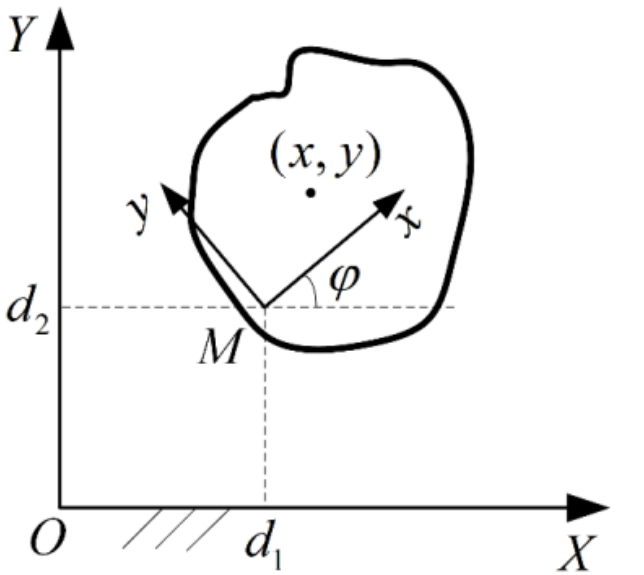
Figure 2. Coordinate system of rigid-body motion.